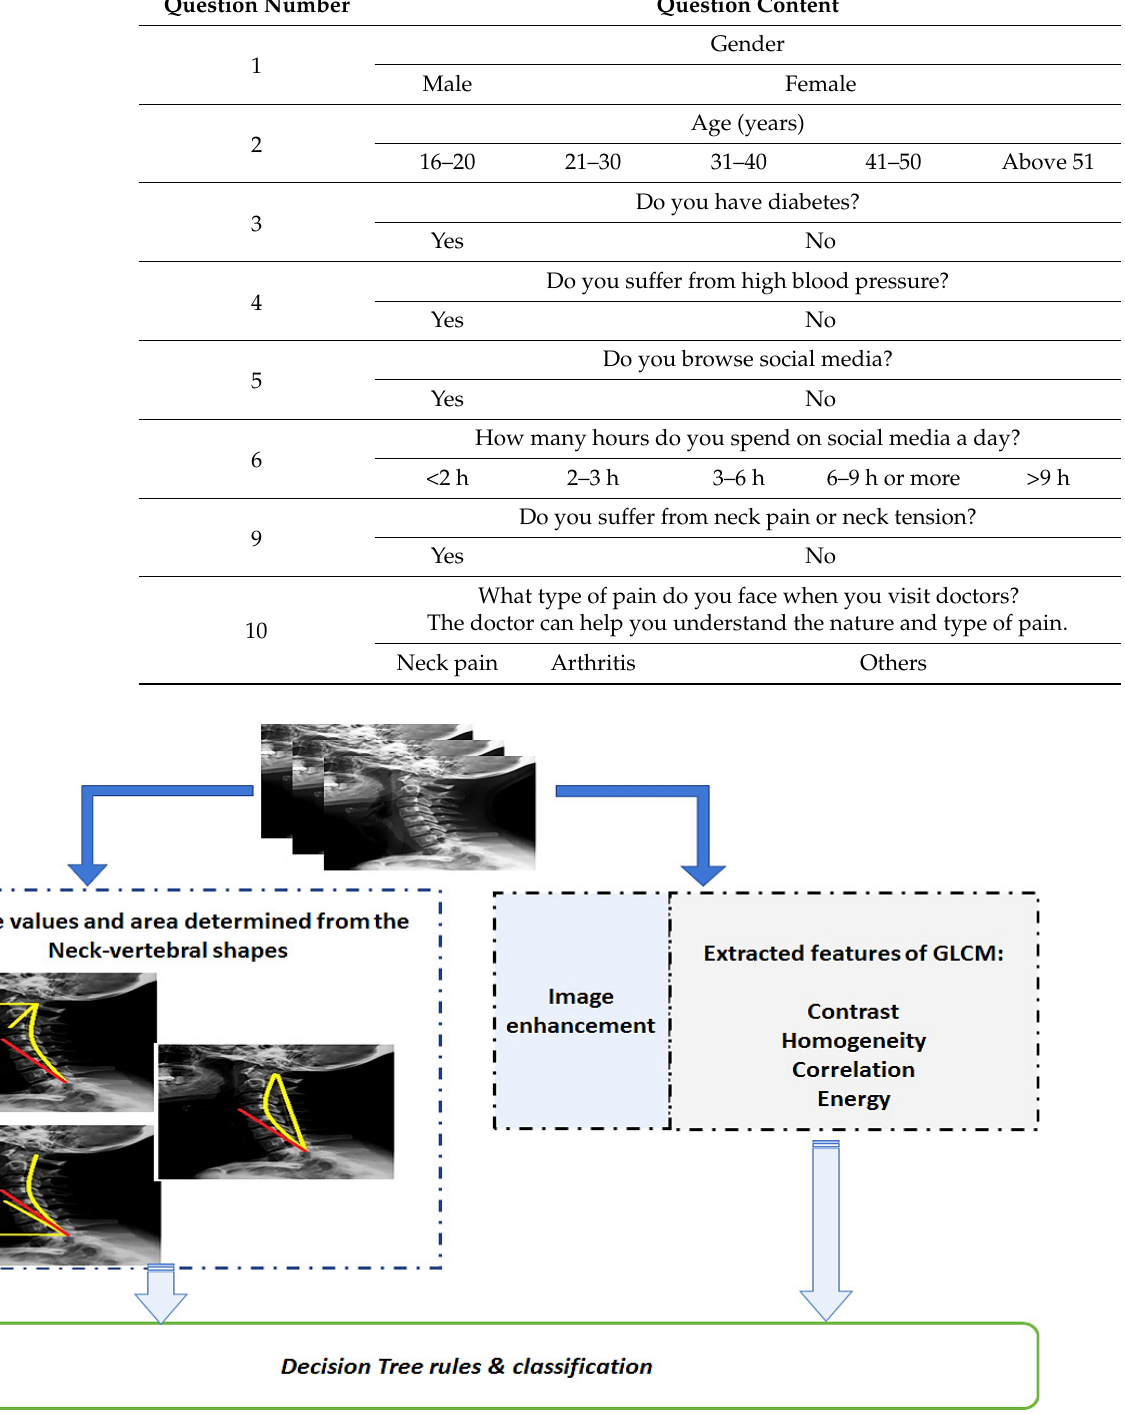
Table 1. Questionnaire (short survey) provided to patients during the orthopedic visit.